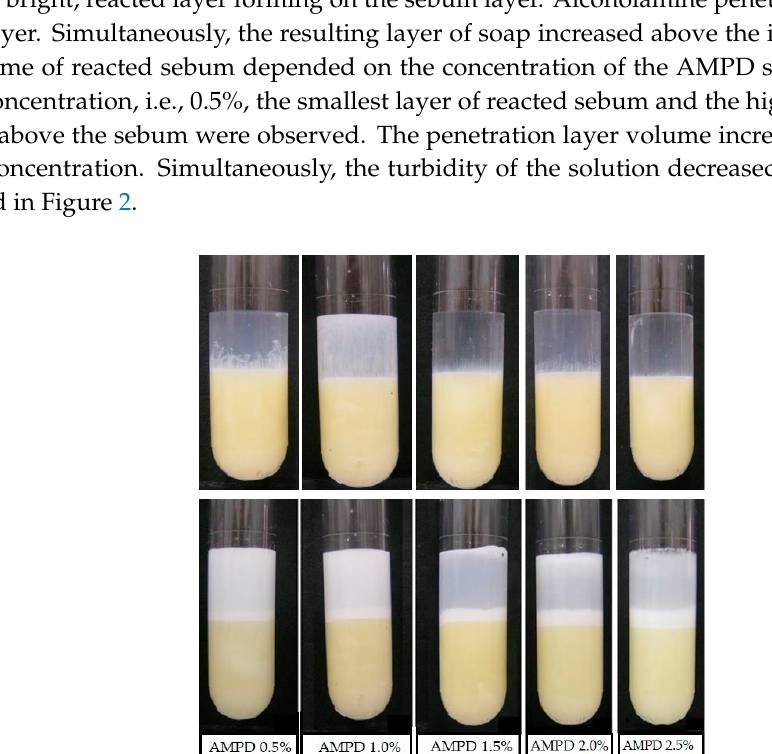
Figure 2. The reaction of AMPD (2-amino-2-methyl-1,3-propanediol) solutions of various concentrations with the components of model skin sebum. Line 1—At time = 0, line 2—After four hours of observation.